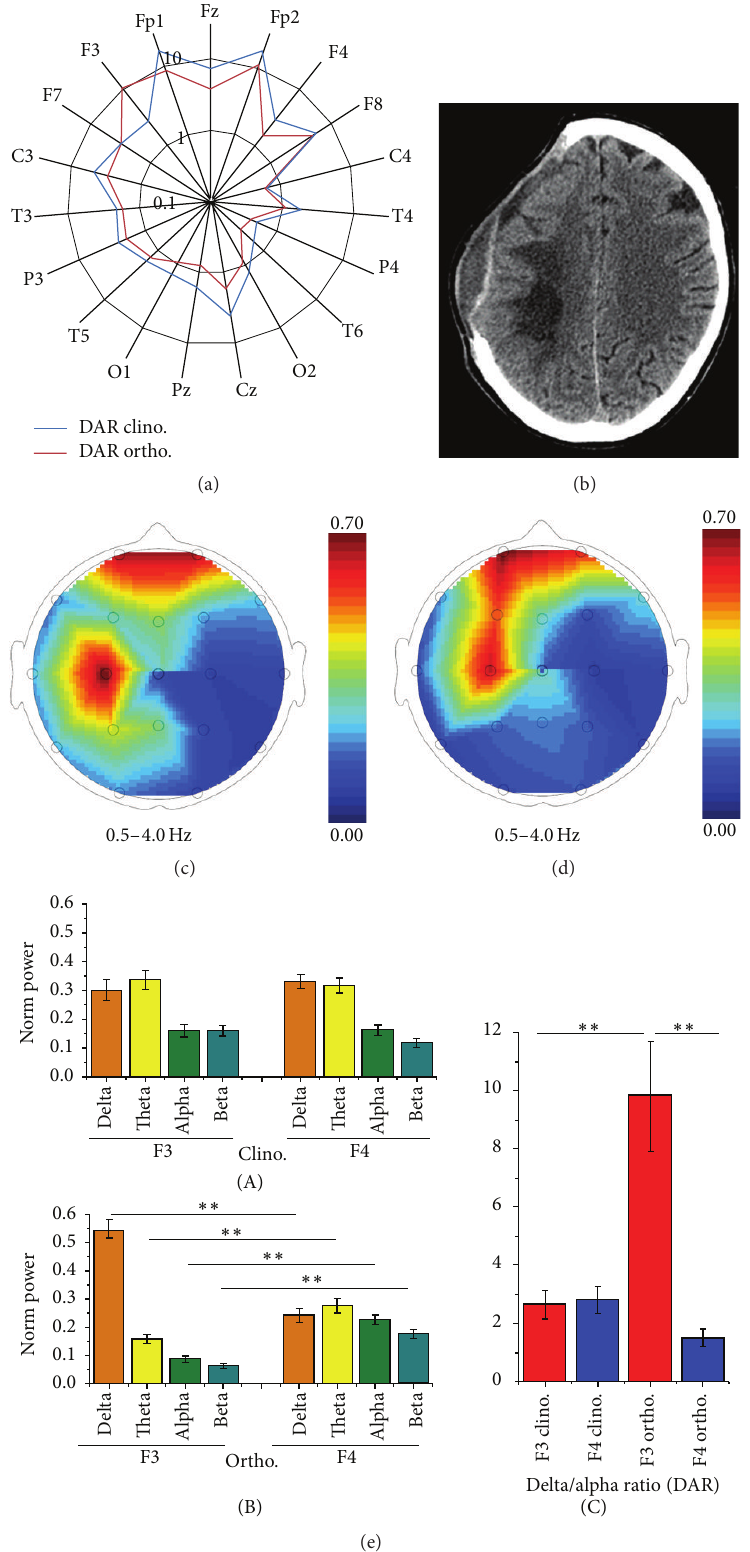
Figure 1: Precranioplasty findings. DAR value for each electrode in clino- and orthostatic positions, shown on a logarithmic scale (a). Brain CT scan showing the posthemorrhagic lesion and extent of craniotomy (b). Delta power band distribution maps in clino- (c) and orthostatic (d) positions. Mean normalized band powers of F3 and F4 signals in clino- ((e)(A)) and orthostatic ((e)(B)) positions. DAR in F3 and F4 in both positions ((e)(C)). ∗∗ indicates 𝑝 < 0.001